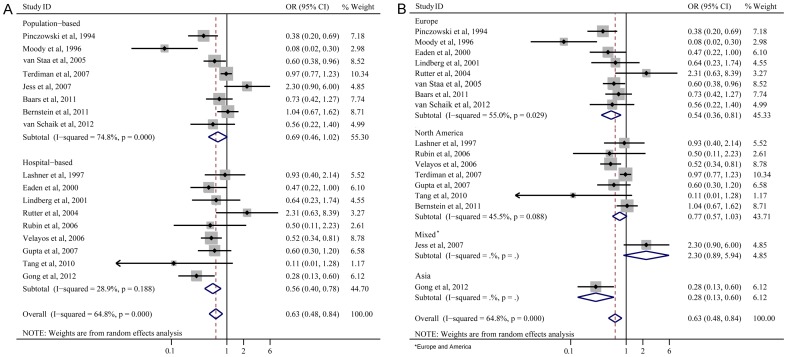
Forest plots of subanalyses of study settings (A) and geographical regions (B).